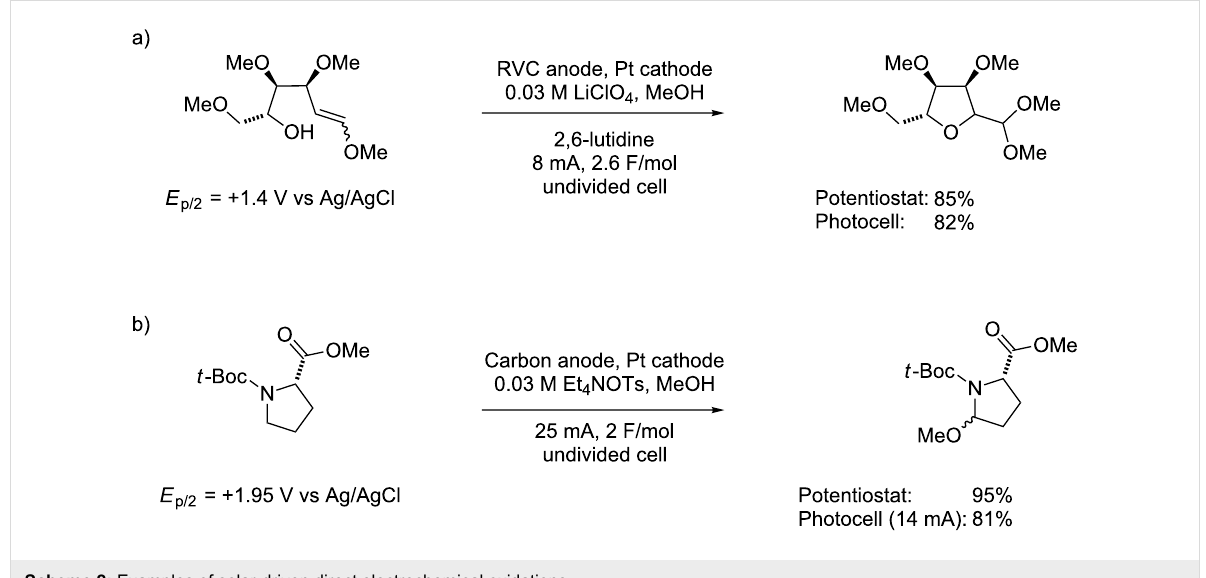
Scheme 2: Examples of solar-driven direct electrochemical